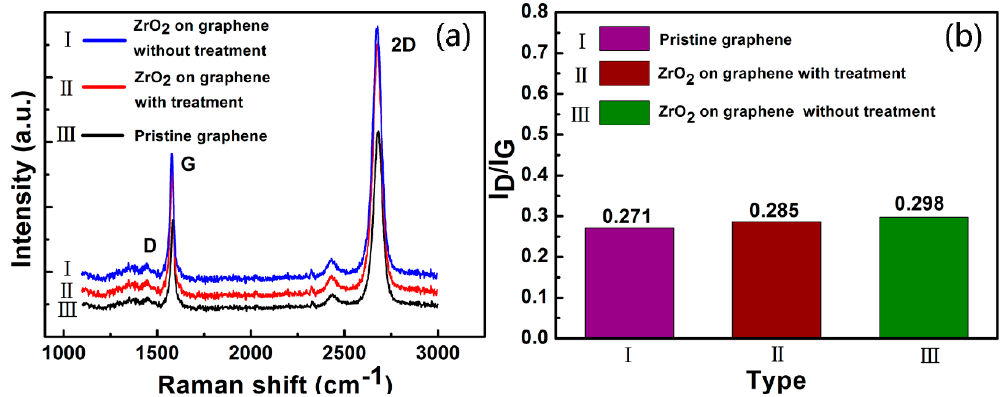
Figure 2. ( a ) Raman spectra and ( b ) the ratio of I D /I G of pristine graphene and graphene covered with 5 nm thick ZrO 2 films with and without surface treatment. 5 nm thick ZrO 2 films with and without surface